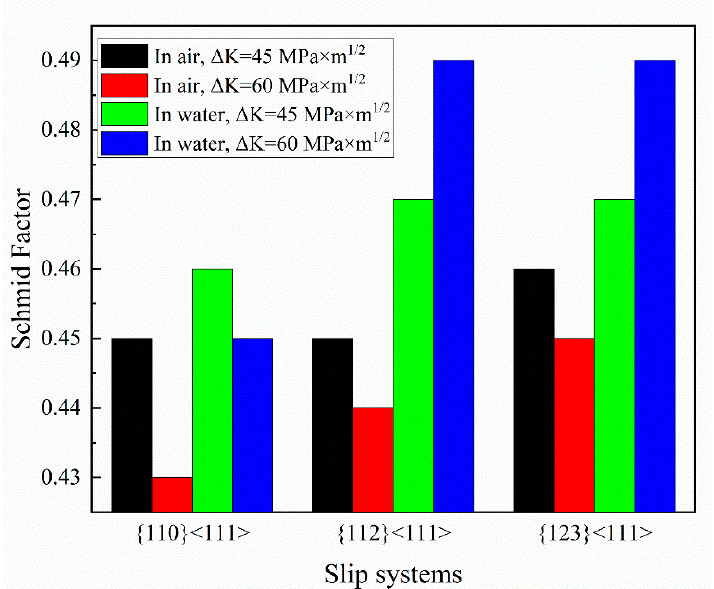
Figure 18. Schmid factor analysis in X80 steel welded joints.